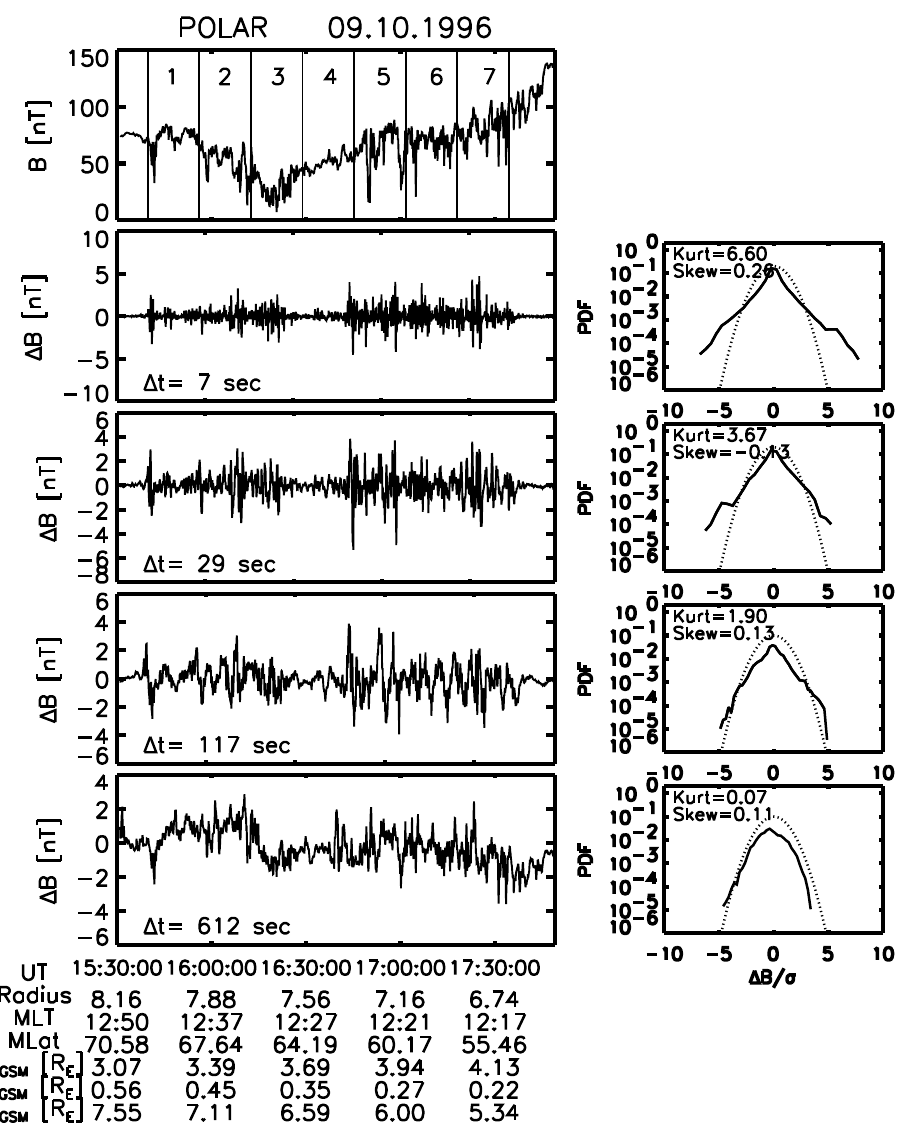
Fig. 1. Total magnetic field B (upper panel) and differences 1B(t) = B(t + 1t) − B(t) . Right plots show the probability distribution function of 1B normalized to its standard deviation. The dotted curve represents the equivalent Gaussian distribution. Kurtosis and skewness are also given. The data segments used in the analysis are marked with vertical lines in the upper